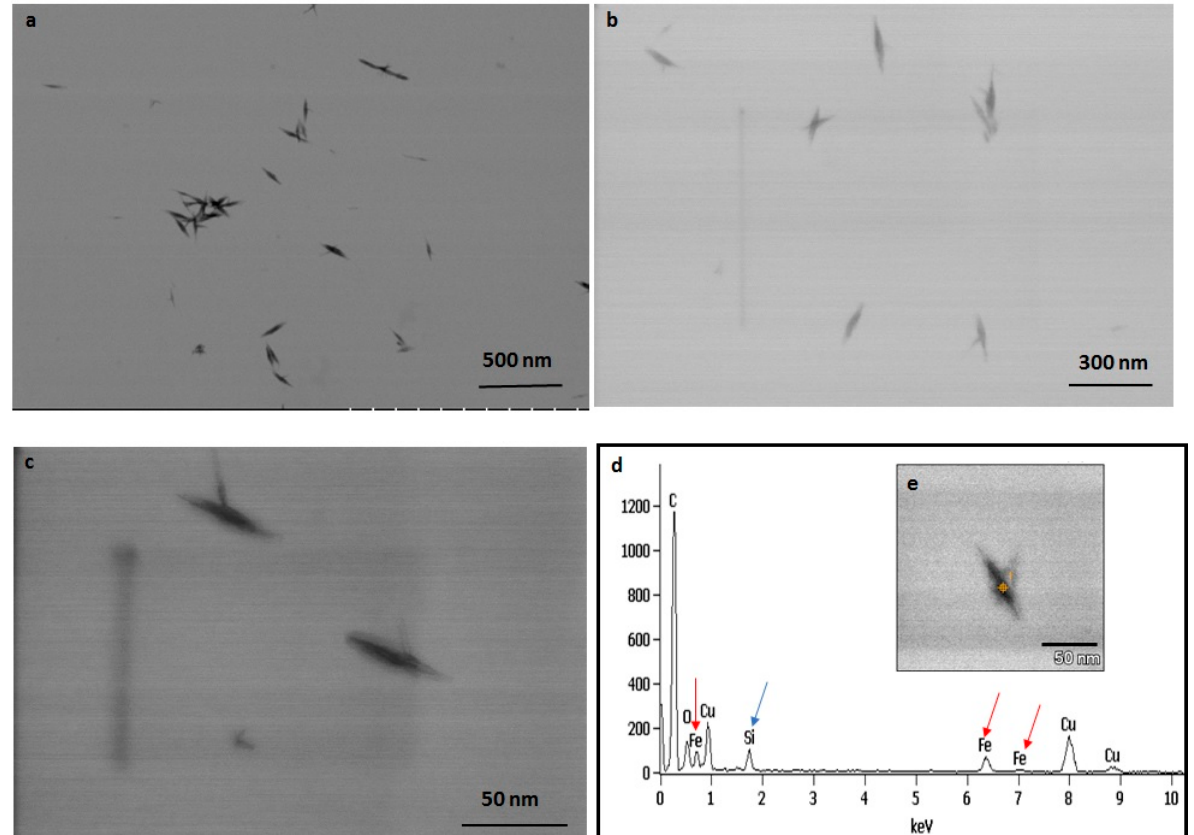
Figure 7. TEM images of extracted IONPs from particle loaded frustules captured in various magnification ( a – c ). EDAX study of single particle confirming presence of iron, silica and oxygen ( d ). TEM image of single spindle shaped IONP ( e ).